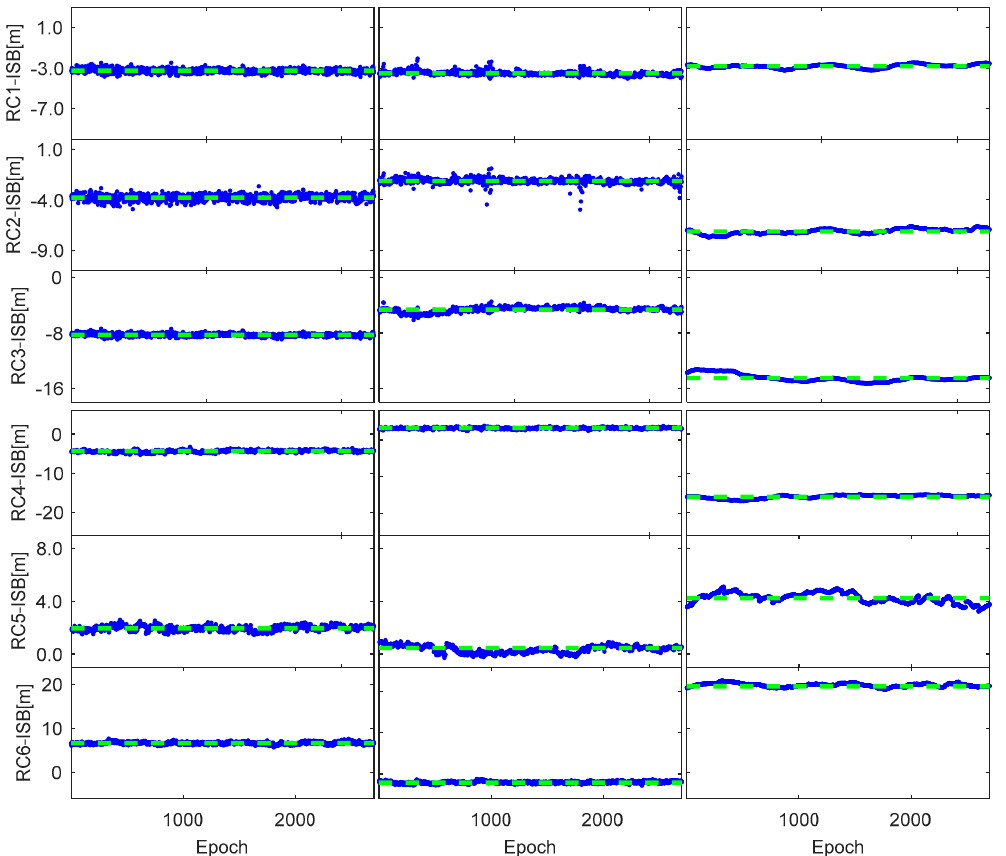
Figure 2. Inter-system bias (ISB) estimations from different tightly coupled methods. The columns from left to right correspond to L1TC, L2TC, and the IF-based tightly coupled (IFTC) method, respectively. The ISB estimations are represented by blue and the mean of the ISB estimations is represented by green. The columns from top to bottom are the ISB estimations of receiver pairs RC1, RC2, RC3, RC4, RC5, and RC6.